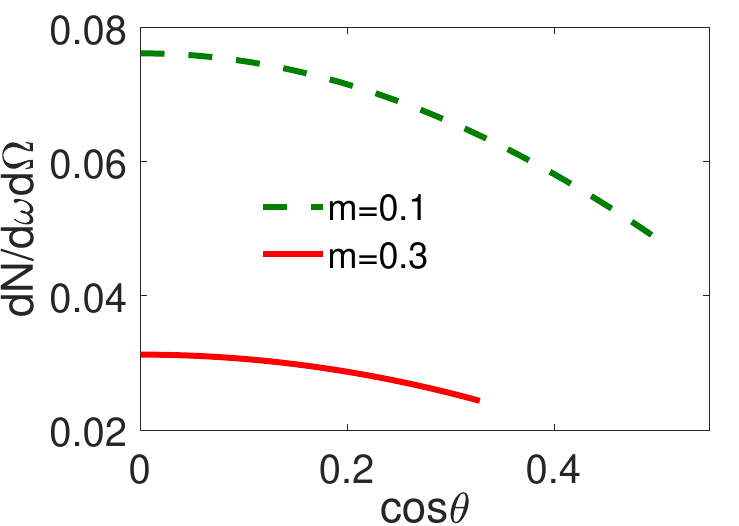
Figure 3. The angular spectra of the vacuum radiation, with the prefactor TS q 0 set to be